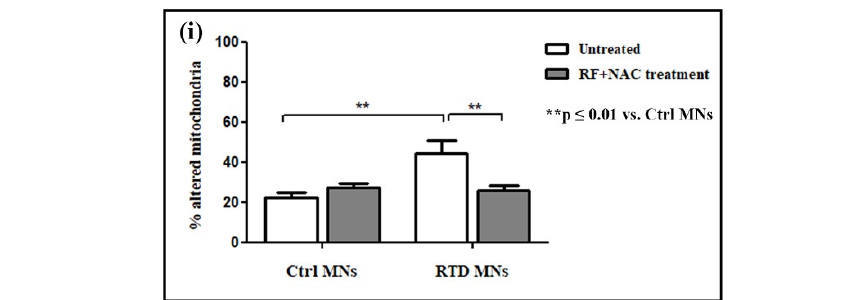
Figure 2. Ultrastructural analysis of RTD vs. Ctrl MNs, before and after riboflavin (RF) + N-acetylcysteine (NAC) treatment. ( a – d ) FIB/SEM micrographs show the presence of several altered mitochondria in RTD MNs, with swollen morphology and deranged cristae ( a , c ), as opposed to regularly shaped organelles in Ctrl cells ( b , d ). After RF + NAC treatment ( e – h ), improved mitochondrial ultrastructure in RTD MNs is observed. ( i ) Statistical analysis demonstrates a significantly higher number of damaged mitochondria in RTD MNs as compared to Ctrl. RF + NAC treatment restores mitochondrial morphology in RTD MNs (** p ≤ 0.01 vs. Ctrl MNs). Scale bars, 1 µ m. N, nuclei; m, regular mitochondria; ly, lysosomes; black arrows, altered mitochondria; black arrowheads,